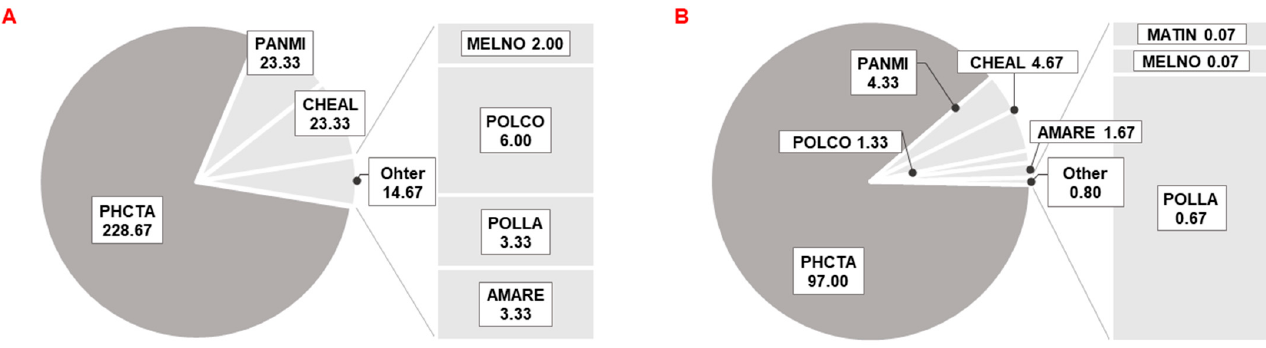
Figure A8. Number of plants per m 2 —Sowing 2 (22nd of April) in 2020 ( A ) and leaf coverage in %— Sowing 2 (22nd of April) in 2020 ( B ).